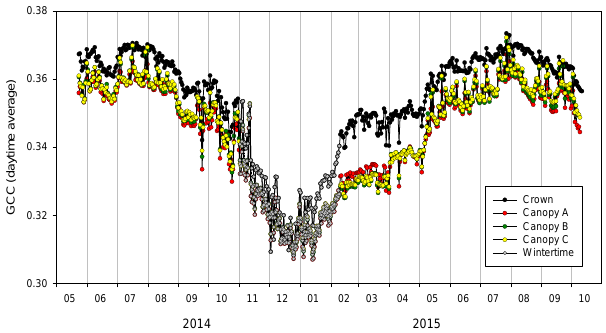
Figure 6. Mean daytime (10:00–14:00, local winter time) GCC val- ues of different ROIs from two forest cameras during the measure- ment period of May 2014 to October 2015. The grey circles indicate the wintertime data that are influenced by an insufficient light level.